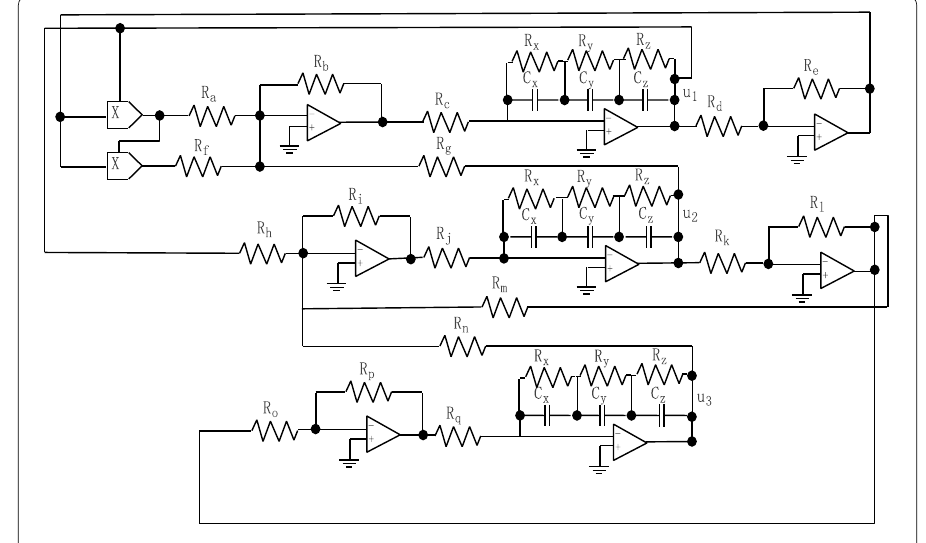
Figure 3 Simulation circuit of FOCH chaotic system (12)